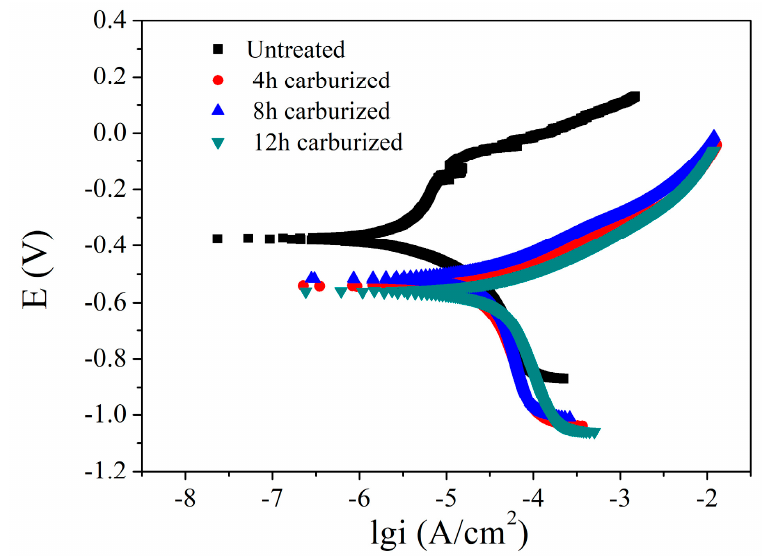
Figure 3. Polarization curves of AISI 420 stainless steel plasma carburized at 460 °C for 4–12 h. Table 1. Parameters obtained from polarization curves of AISI 420 stainless steel plasma carburized at 460 °C for 4–12 h.